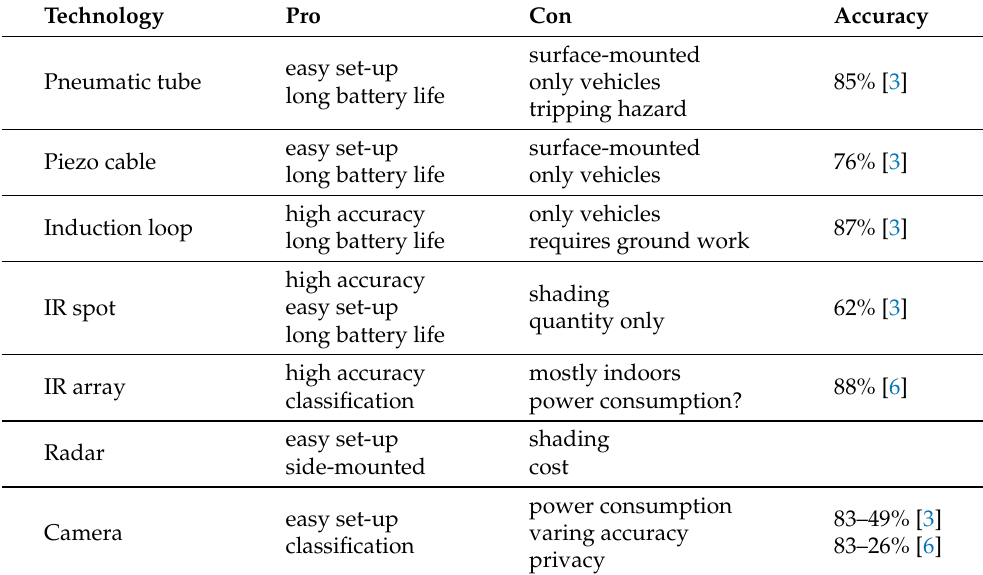
Table 2. Technology overview